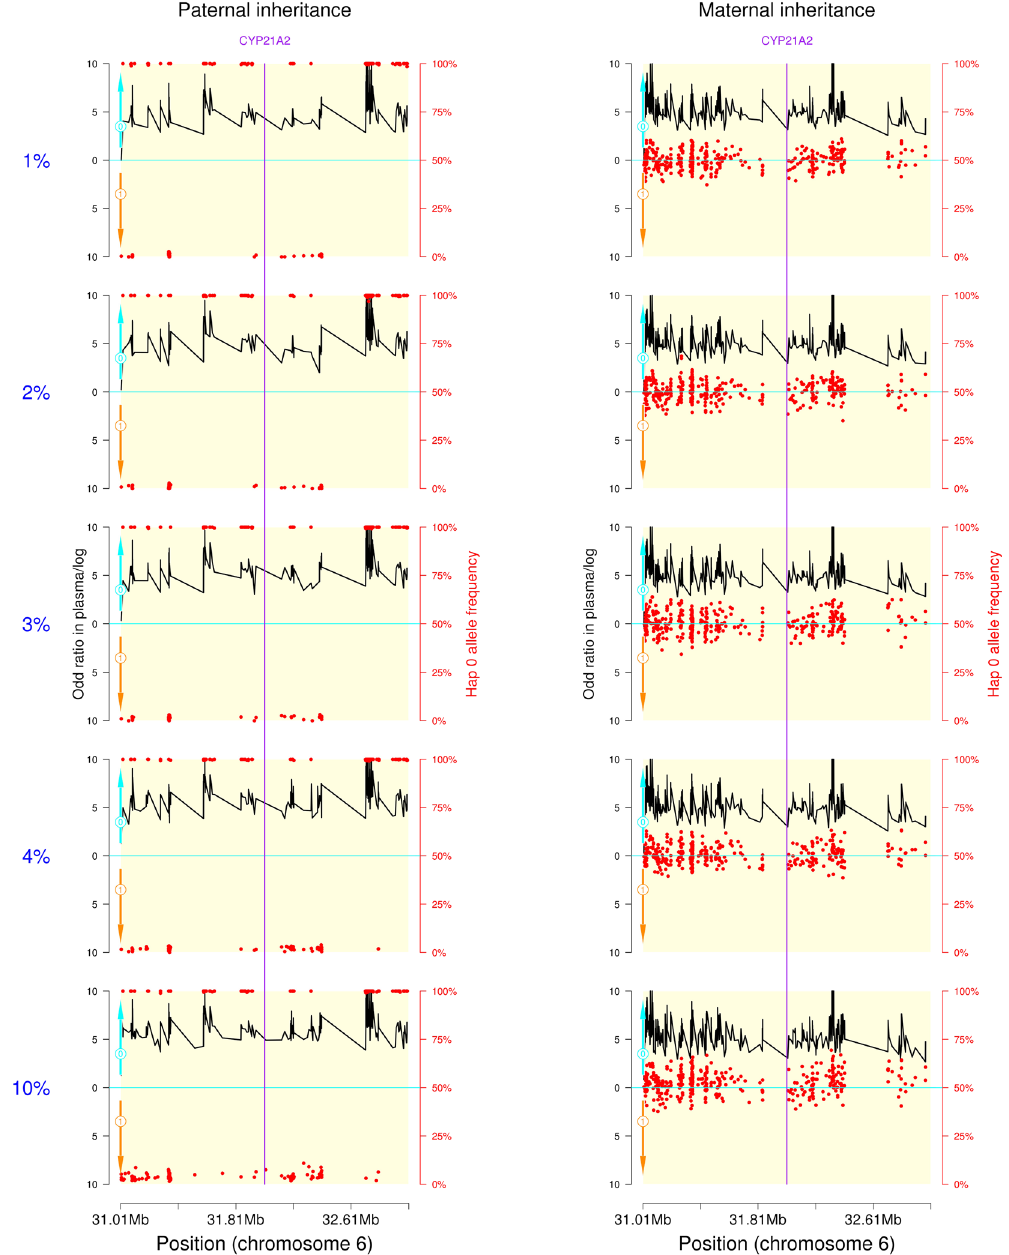
Figure 1. Fetal genotype determination in artificial mixtures. The inheritance of paternal haplotype is displayed on the left, and inheritance of maternal haplotpe on the right. Hap 0 was linked to the pathogenic mutation in CYP21A2 , while Hap 1 was linked to wild-type allele. The red points represent the frequency of Hap 0 alleles at each informative SNP site. The black lines indicate haplotype inheritance by the fetus. The logarithmic odds ratio of transmission probability between Hap 0 and Hap 1 was calculated by P0 * P0re/(P1 * P1re), where P0re is the probability of recombination during fetal inheritance Hap 0, and P1re is the probability of recombination if fetus inherited Hap